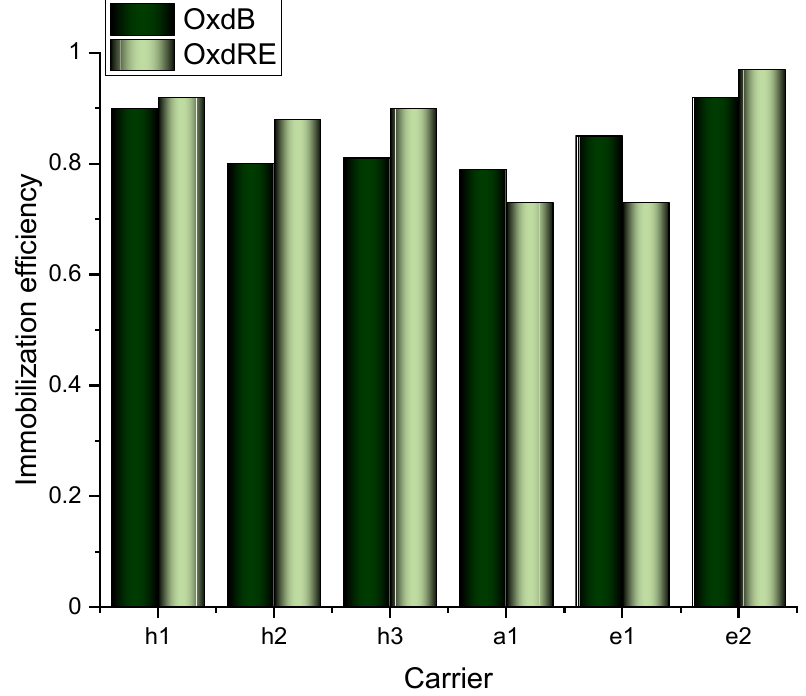
Figure 1. Immobilization efficiency of purified OxdB and OxdRE on different carriers.